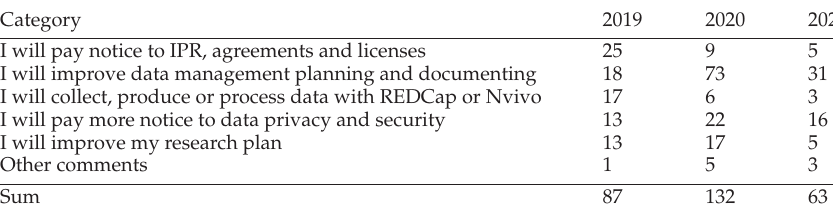
Table 4: How will the things you have learned change your practices?